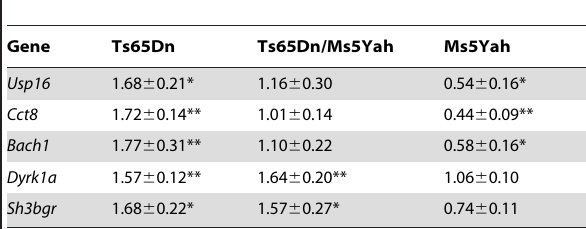
Table 5. Ratio of the expression level of 5 genes located on Mmu16 in the heart of mutant compared to disomic control